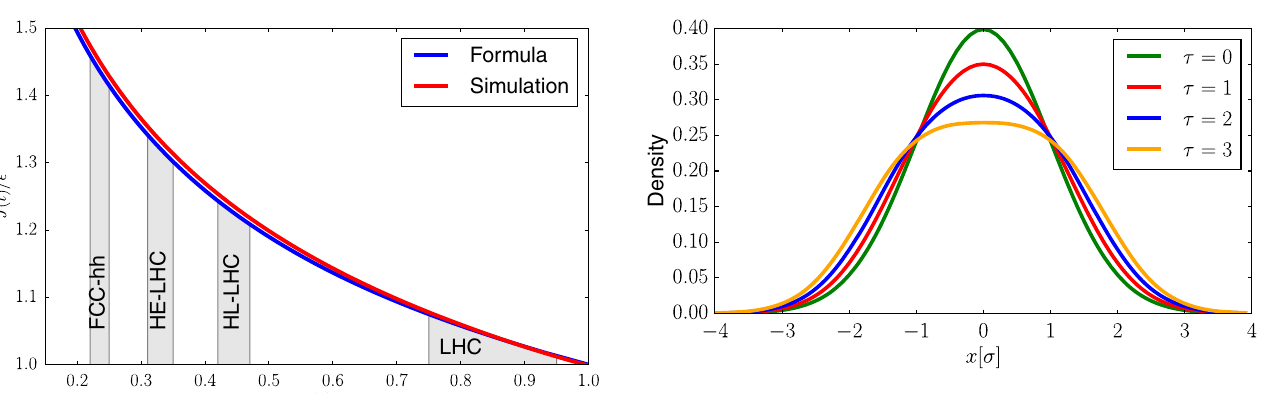
FIG. 5. Particle densities in the horizontal direction for τ ¼ 0 , 1, 2, and 3, corresponding to 0%, 50%, 74%, and 86% burn-off.